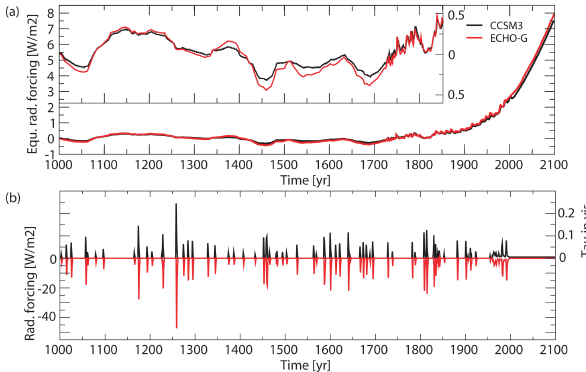
Fig. 1. Forcing from 1000 to 2100AD for the CCSM3 (black) and the ECHO-G (red) transient simulations: (a) solar and equivalent CO 2 forcing (including CO 2 , CH 4 , and N 2 O) with respect to mean of the period 1500–1899, and (b) the forcing representing volcanic eruptions. The forcing in (a) is represented after conversion to the equivalent radiative forcing, assuming a planetary albedo of 0.31 and using the simplified formula given in IPCC (2001, Table 6.2). The inset in (a) focuses on the forcing functions from 1000 to 1850AD. In (b) the optical depth in the visible band represents the volcanic forcing of the CCSM3 simulations, whereas in ECHO-G the volcanic forcing is just implemented by changes of the solar